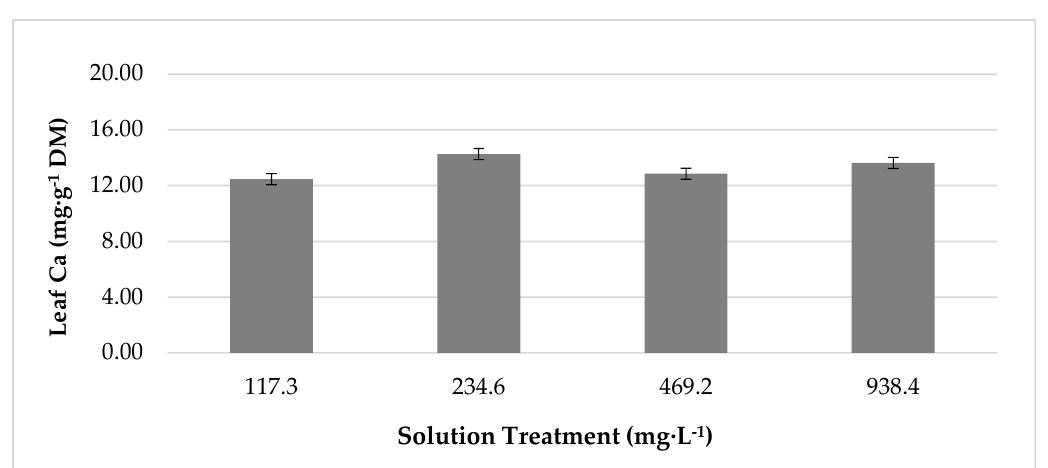
0.001, respectively.